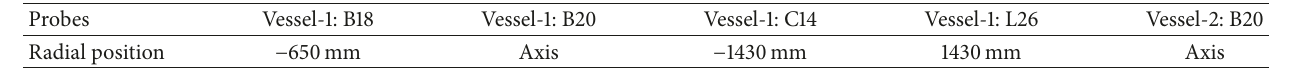
Table 3: Radial position of the probes.